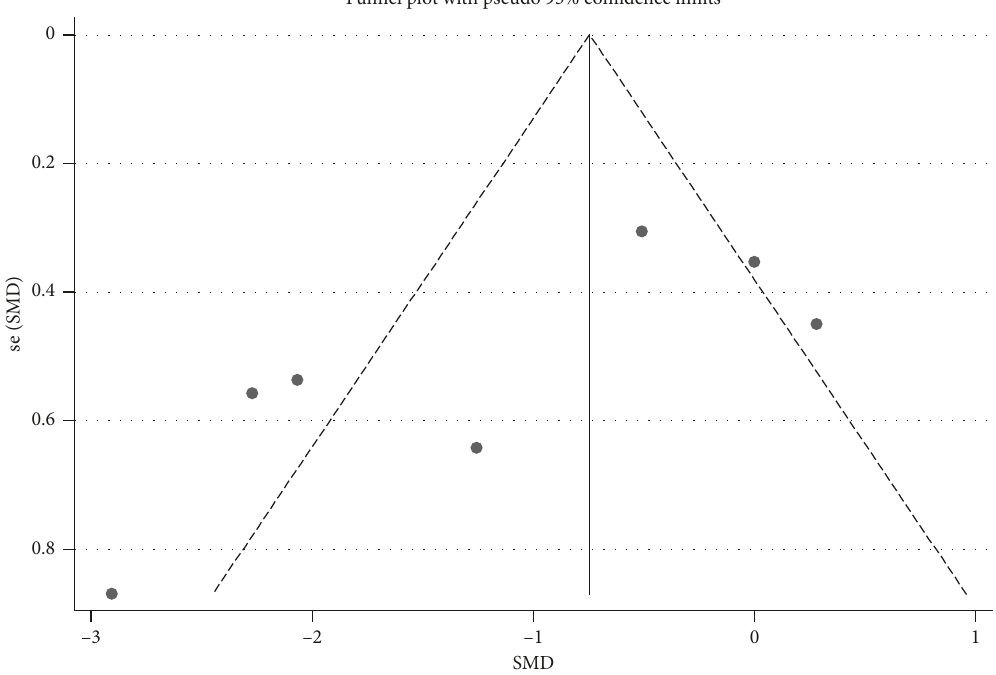
Figure 5: Funnel plot for publication bias in selection of